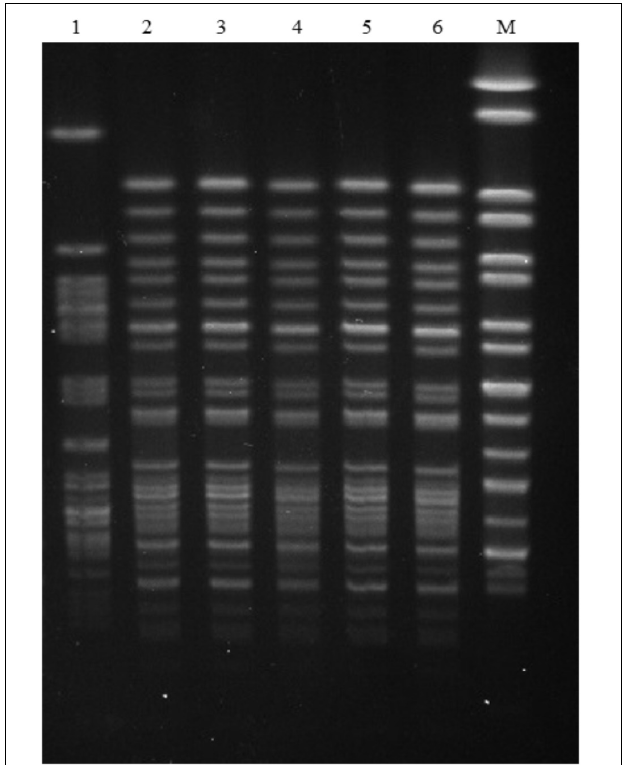
FIGURE 1 | PFGE patterns of five mcr-1 -carrying E. coli ST93 strains in this study and the mcr-1 - carrying E. coli ST93 strain PET01 that was isolated from a cat in a pet shop from Guangzhou (Zhang et al., 2016). Lanes: (1) PET01; (2) GZ6DS2; (3) GZ6DS9; (4) GZ6CS9; (5) GZ6DH17; (6)